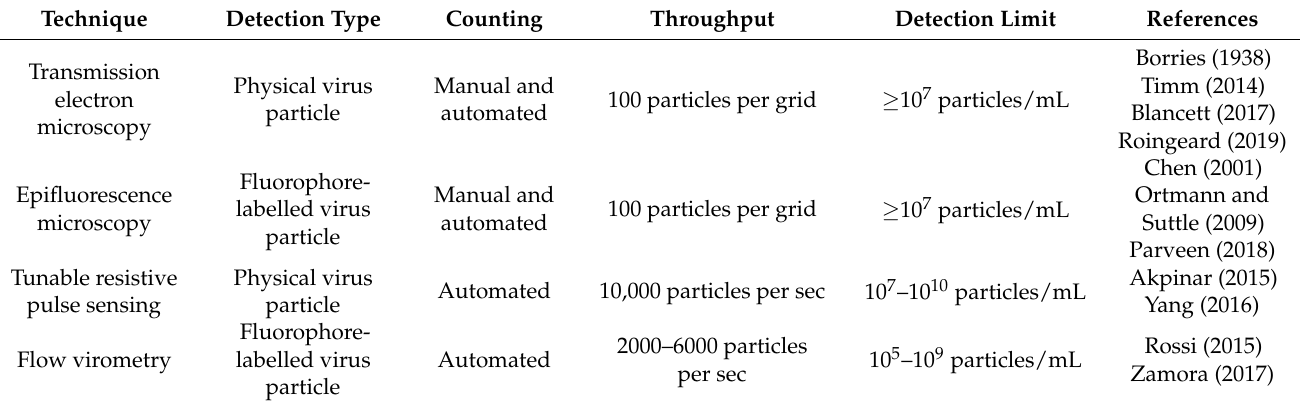
Table 1. Virus particle quantification techniques and their